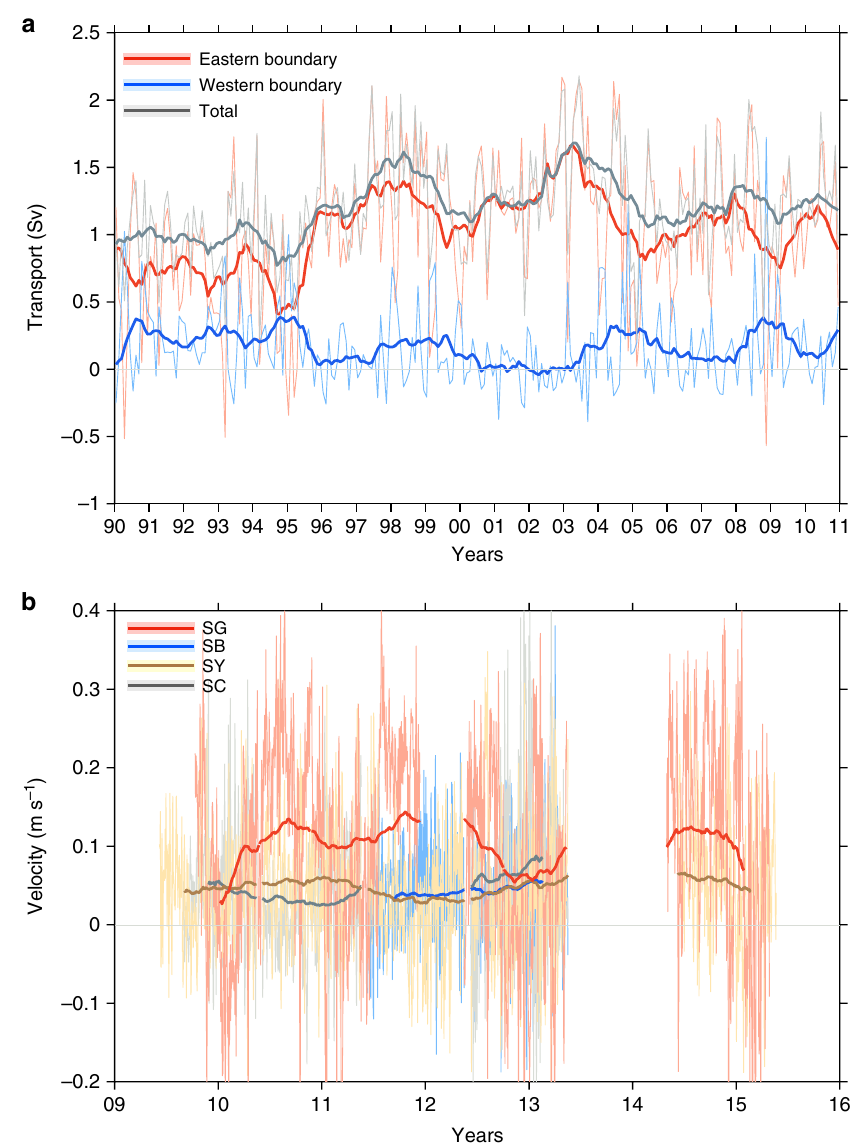
Fig. 6 The deep jet is the main conduit of the over fl ow. a Volume transport (positive means southwards into the North Atlantic Ocean) estimated from the model for the western and eastern boundaries in the Faroe – Shetland Channel (FSC) (Supplementary Fig. 1, inset) and for depths deeper than ~500 m (see Methods section). b Velocities (positive means southwards) from the Acoustic Doppler Current Pro fi ler (ADCP) moorings stretching across the FSC on both daily (thin) and interannual (thick, 360-day running mean) time scales. Figure 1b shows the location of the ADCP mooring pro fi les sites in the FSC. Note that the Faroe – Shetland Channel jet (FSCJ) is strongest in both the model and the SG mooring (red